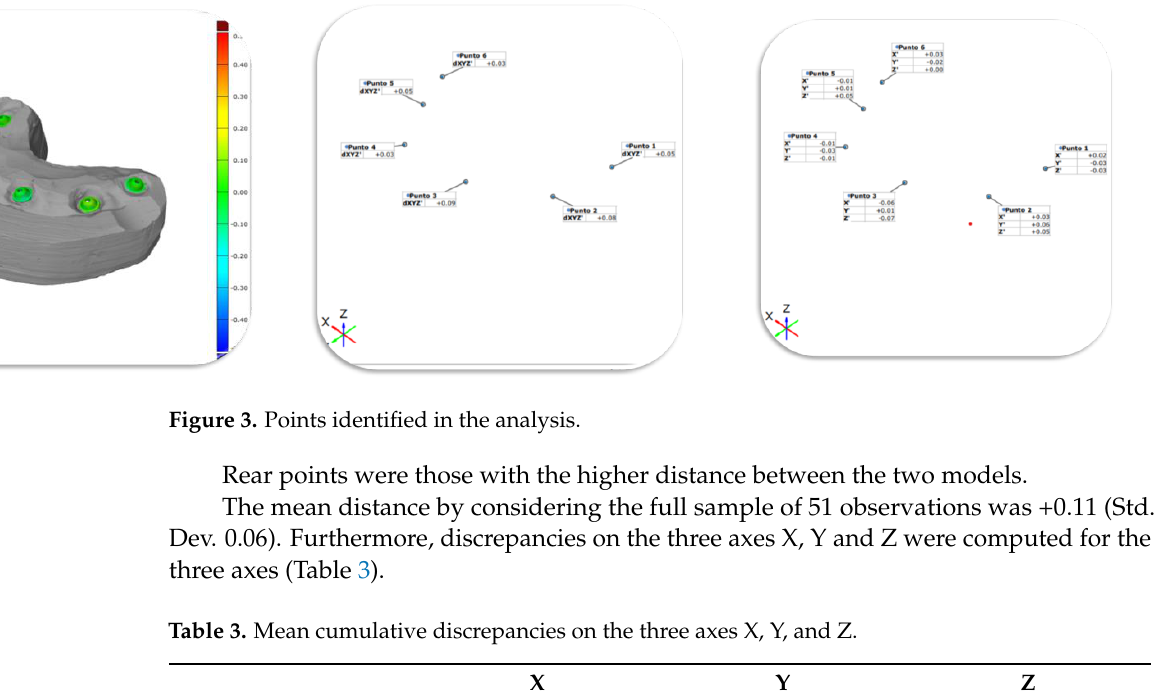
Figure 3) evaluated with the optical 3D method (mm).